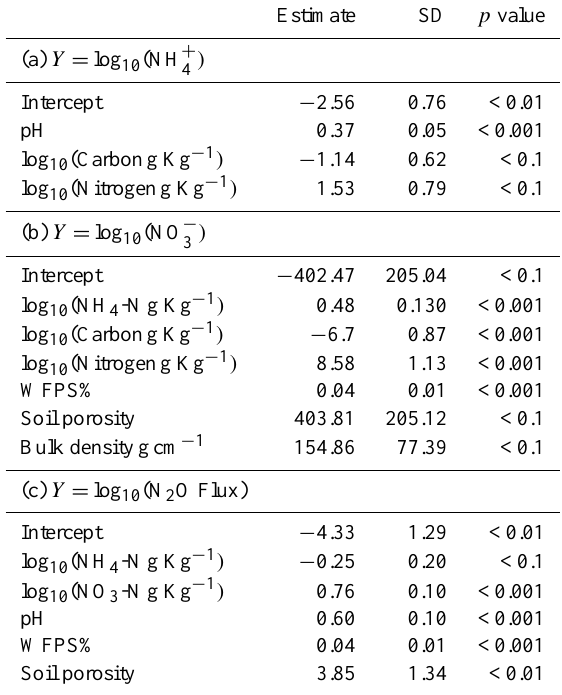
Table 2. Multiple linear regression correlation of soil properties and N 2 O flux as plotted in Fig. 6.